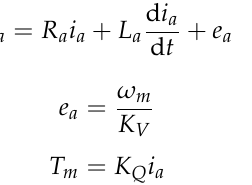
represents represents motor armature T represents torque m